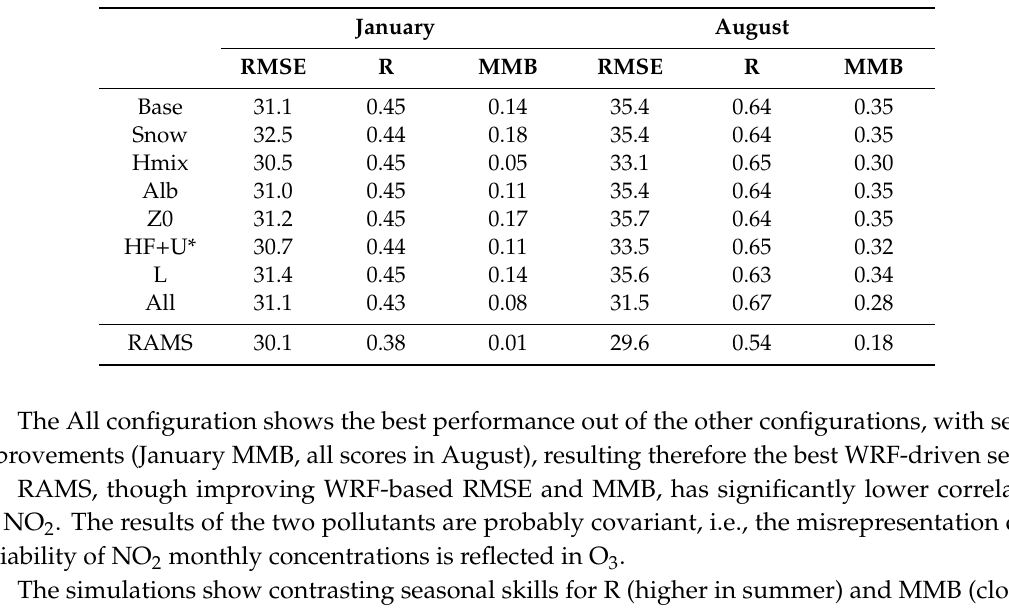
Table 4. O 3 —monthly RMSE ( µ g / m 3 ), R and MMB. Values in bold indicate performance improved (lower RMSE and MMB, higher R) with respect to the Base